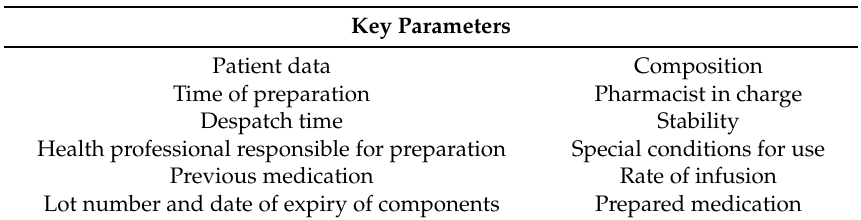
Table 1. Key parameters of an intravenous